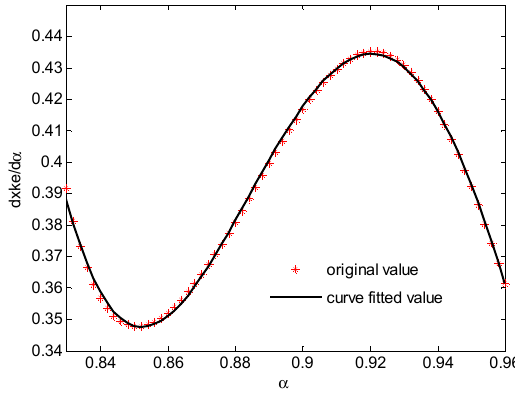
x α α∂ ∂ . Figure 8. Polynomial fitted result of ∂ x ke ( α ) / ∂α . ke